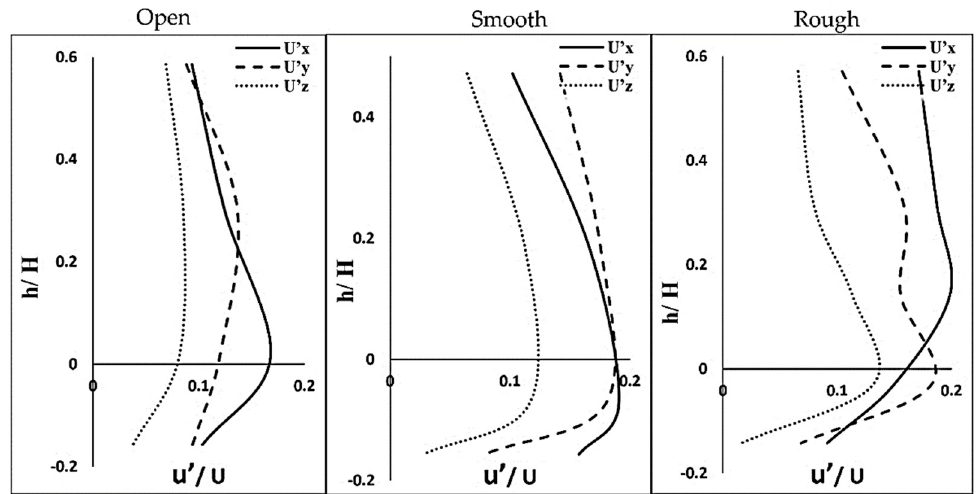
Figure 16. Turbulence intensity in three directions under different surface cover conditions with the dike orientation of 90° (water depth: 35 cm). ADV measurements subject to +/- 0.25 cm/s error.